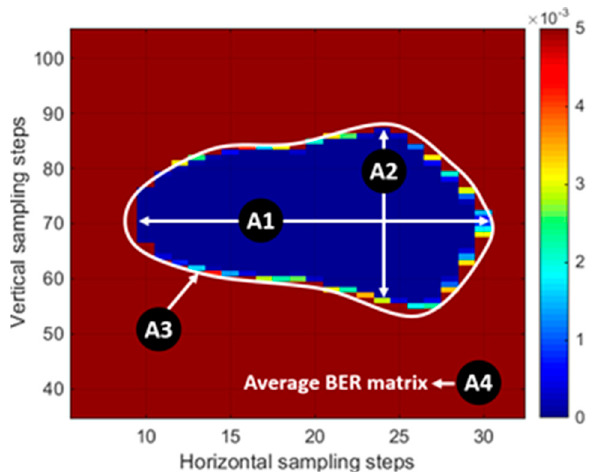
Figure 6. Feature sets based on the BER matrix.